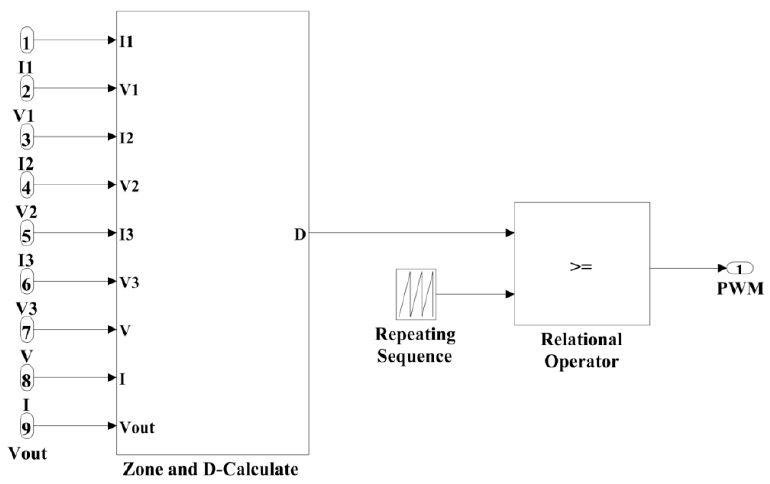
Figure 9. Subsystem model of GMPPT control.